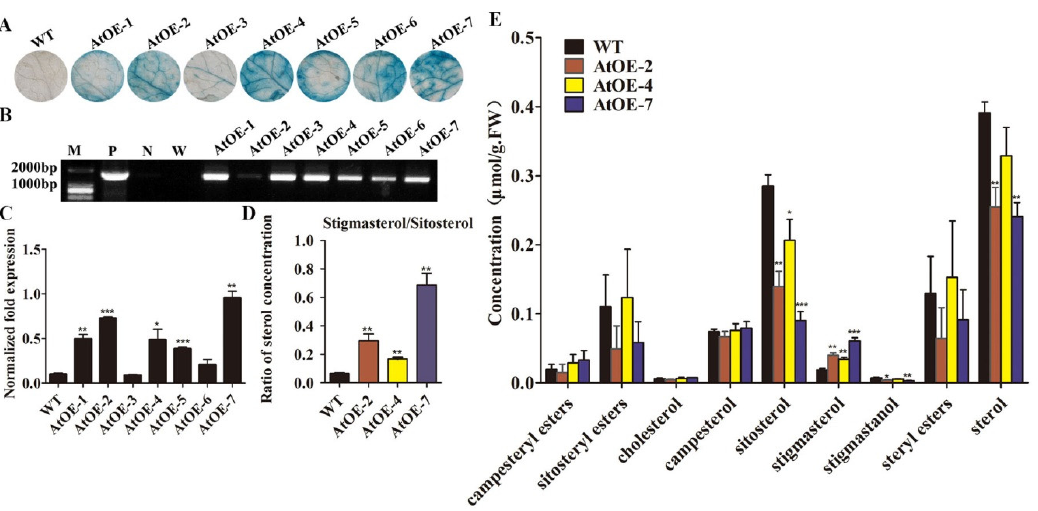
Figure 4. Identification of ectopic expression of GhCYP710A1 gene in Arabidopsis and the change of sterol profiles in transgenic plants and control plants. ( A ) GUS histochemical identification of transgenic Arabidopsis . ( B ) Molecular identification of transgenic Arabidopsis . Two primers that recognized CaMV 35S promoter and the 3 ′ -sequence of GhCYP710A1 were used in PCR system. M: DNA marker; P: positive control using the pLGN-GhCYP710A1plasmid as template; N: negative control using wild-type Arabidopsis gDNA as template; W: empty control using water as template; AtOE- 1~AtOE-7: transgenic Arabidopsis plants 1# to 7#. ( C ) Relative expression level of GhCYP710A1 in the transgenic Arabidopsis . ( D ) The ratio of stigmasterol to sitosterol. ( E ) The content of various free sterols and sterol esters in wild-type and transgenic Arabidopsis . Control: wild-type Arabidopsis (Col- 0); AtOE-2, AtOE-4 and AtOE-7: transgenic Arabidopsis line 2#, 4# and 7#, respectively. Error bars represent the standard deviation of three independent replicates. * represents p < 0.05, ** represents p < 0.01, *** represents p < 0.001.